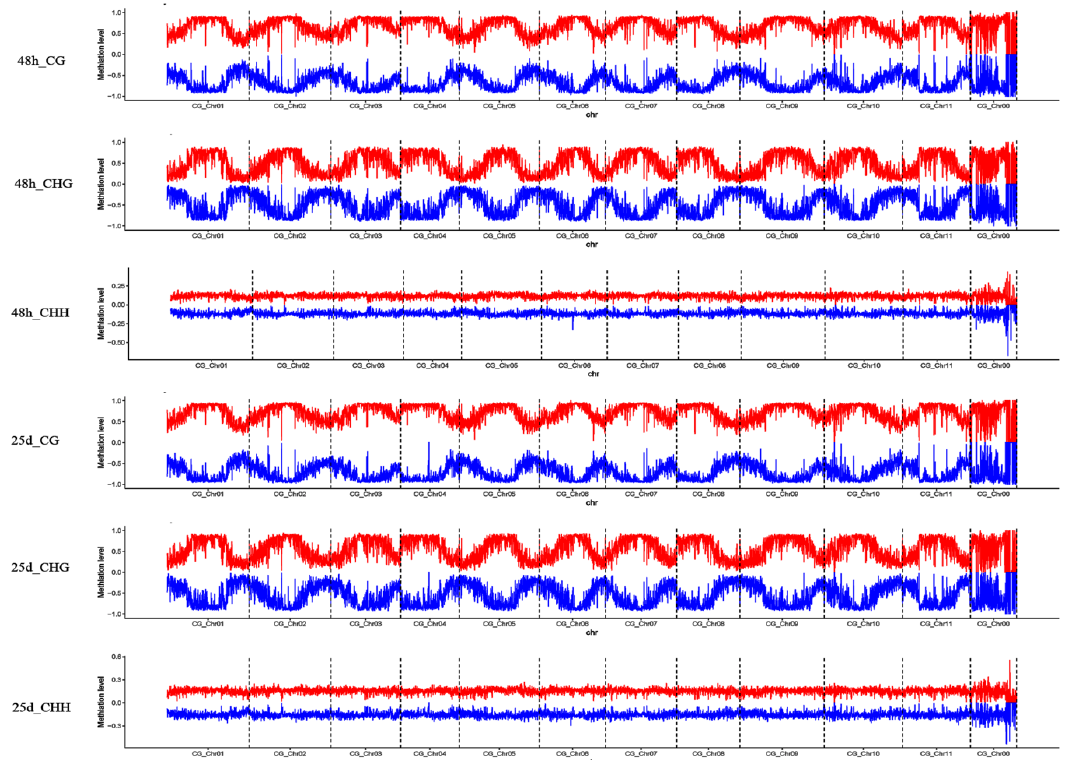
Figure 5. Chromosomal distribution of the global DNA methylation patterns in each sample under CG, CHG, and CHH contexts. CG_Chr00–CG_Chr11 in the x -axis represents chromosome 0–11 of the watermelon “Charleston Gray”. The y -axis represents the methylation level of DNA methylation patterns. The red lines indicate the methylation level in the sense strand of the watermelon genome and the blue lines indicate the methylation level in the antisense strand of the watermelon genome.